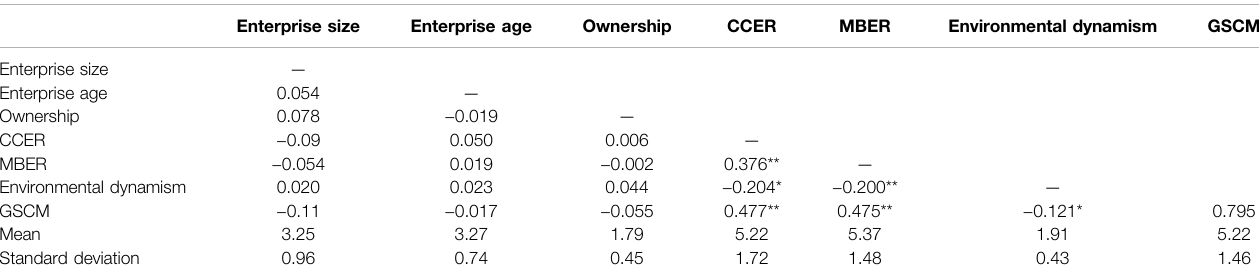
TABLE 5 | Correlation analysis results.